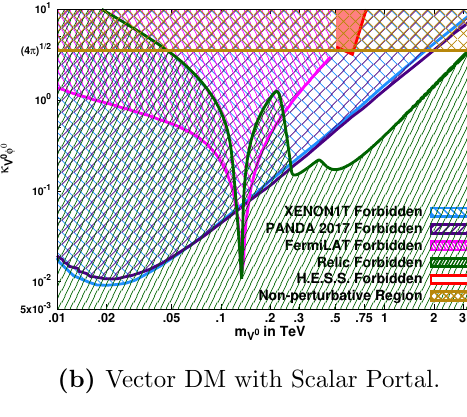
, (cid:17)(cid:30) 0